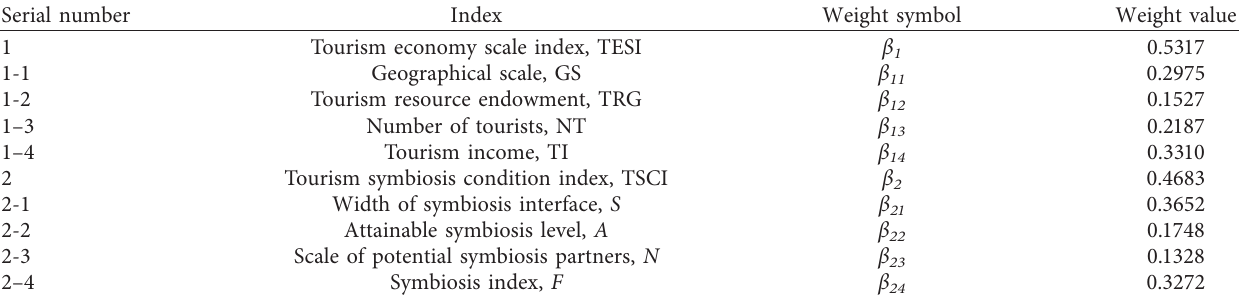
Table 4: Symbiosis unit quality evaluation model.